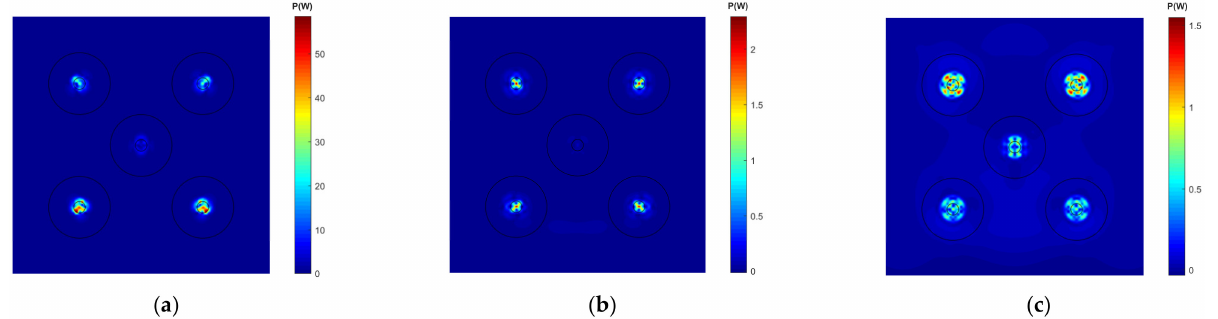
Figure A7. Structural intensity contours of ABHs with BC 1 at different frequencies: ( a ) 1000 Hz, ( b ) 1050 Hz, ( c ) 1100 Hz.